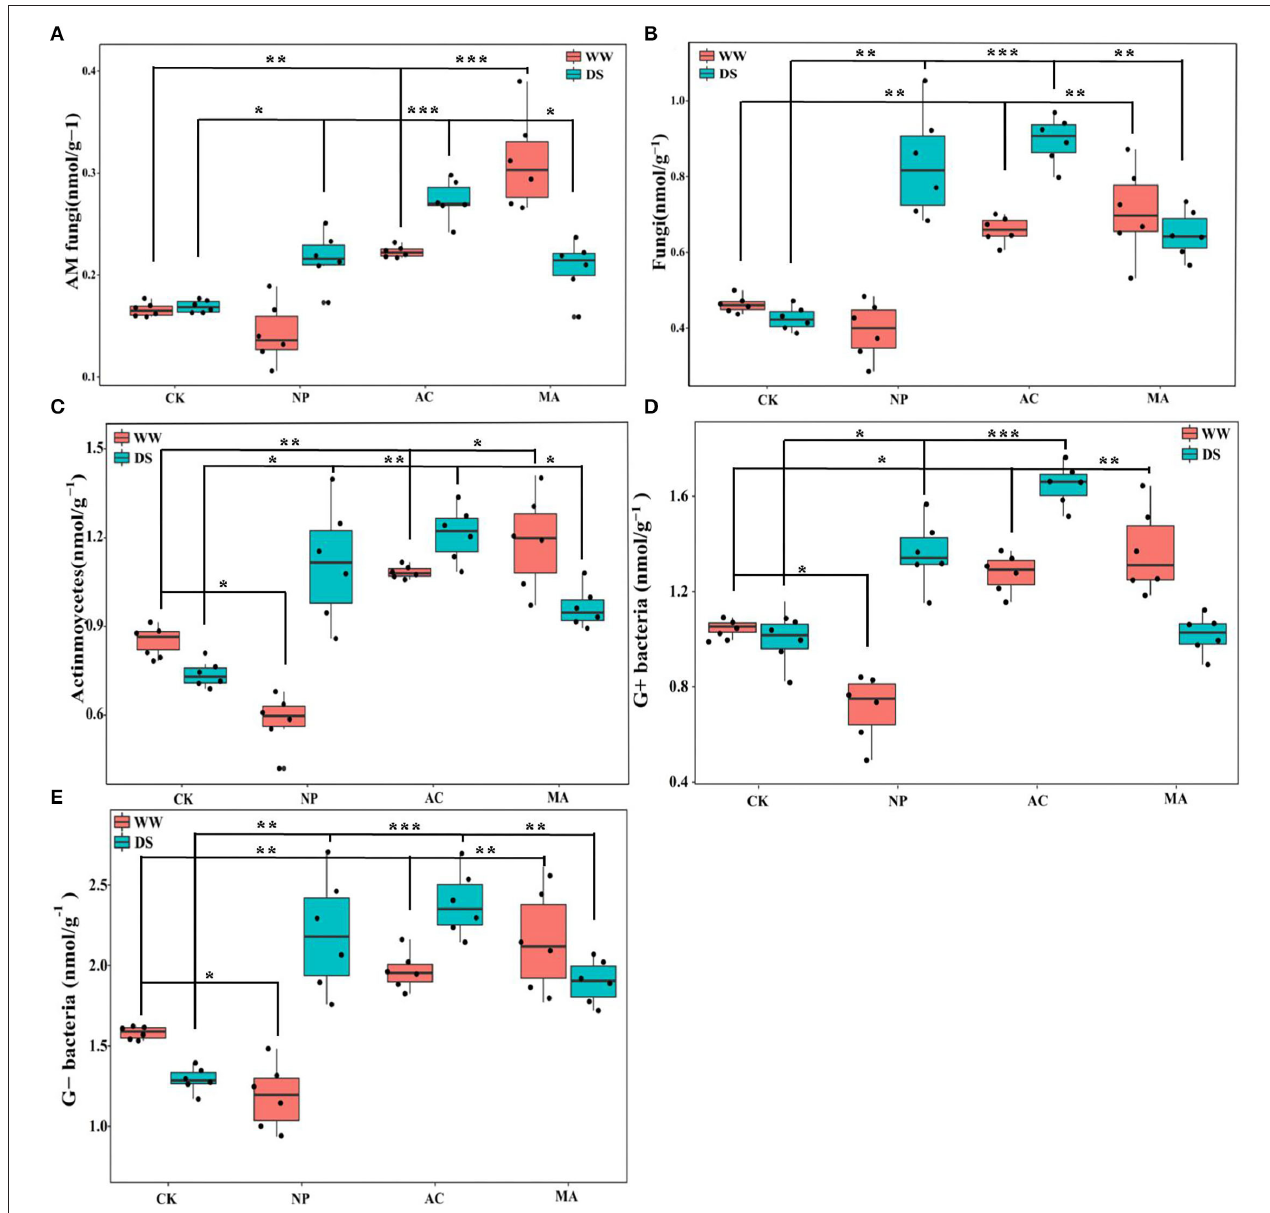
FIGURE 5 | Effects of different dark septate endophyte (DSE) on soil microbial composition of Lycium ruthenicum seedlings. CK, non-inoculated plants; NP, plants inoculated with Neocamarosporium phragmitis ; AC, plants inoculated with Alternaria chlamydospore ; MA, plants inoculated with Microascus alveolaris ; WW, well-watered; DS, drought stress, respectively. AM fungi content of rhizosphere soil (A) , Fungi content of rhizosphere soil (B) , Actinmoycetes content of rhizosphere soil (C) , G + bacteria content of rhizosphere soil (D) , and Gbacteria content of rhizosphere soil (E) . The * symbol indicates the significant difference P < 0.05. The ** symbol indicates the significance level intervenes between P < 0.01. The *** symbol indicates difference is very significant, P <